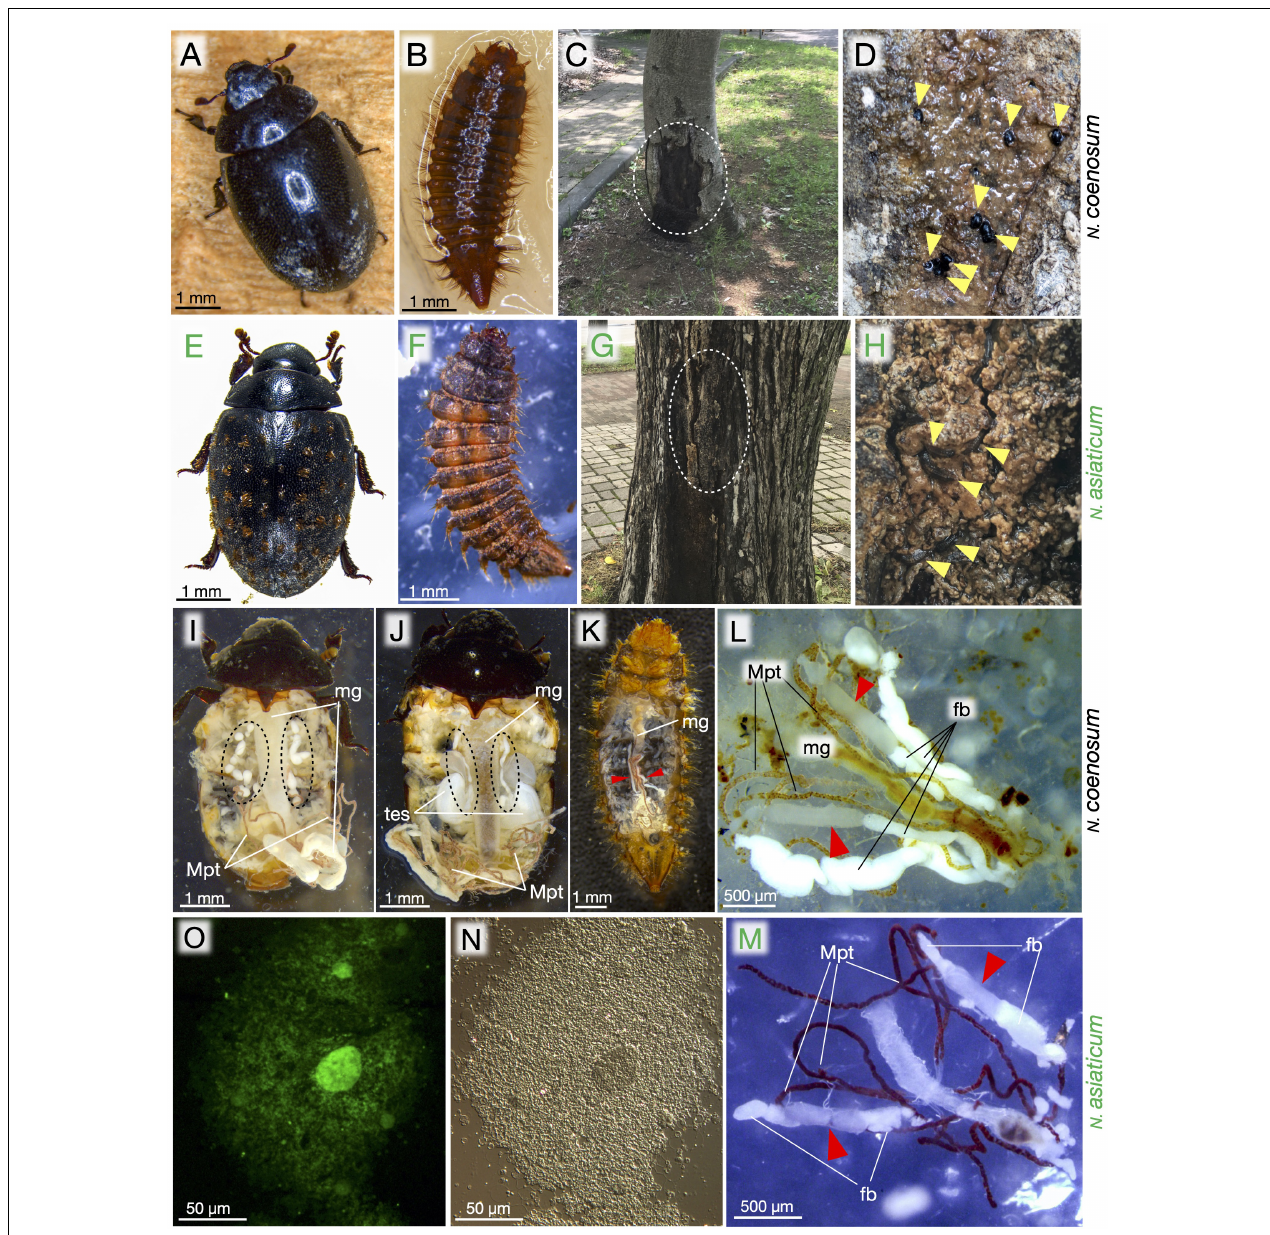
FIGURE 1 | Morphology, ecology, bacteriomes, and endosymbiotic bacteria of Nosodendron beetles. (A–D) N. coenosum . (E–H) N. asiaticum . (A,E) Adults. (B,F) Larvae. (C,D) Habitat of N. coenosum . Tree sap is seeping out of the bark crevices of Idesia polycarpa , where adult beetles are seen (yellow arrowheads). (G,H) Habitat of N. asiaticum . Tree sap is seeping out of the bark crevices of Ulmus davidiana , where larvae are found (arrowheads). (I,J) Dissected adult female (I) and male (J) of N. coenosum , in which paired sausages-shaped bacteriomes are seen on both sides of midgut (dotted circles). (K) A dissected larva of N. coenosum , in which a pair of slender bacteriomes are present on both sides of midgut (red arrowheads). (L,M) Dissected larval bacteriomes (red arrowheads) of N. coenosum (L) and N. asiaticum (M) associated with midgut, fat bodies and Malpighian tubules. (N,O) Differential interference microscopic (N) and epifluorescence microscopic (O) images of endosymbiotic bacteria released from a dissected adult bacteriome of N. coenosum . fb, fat body; mg, midgut; Mpt, Malpighian tubule; tes, testis.